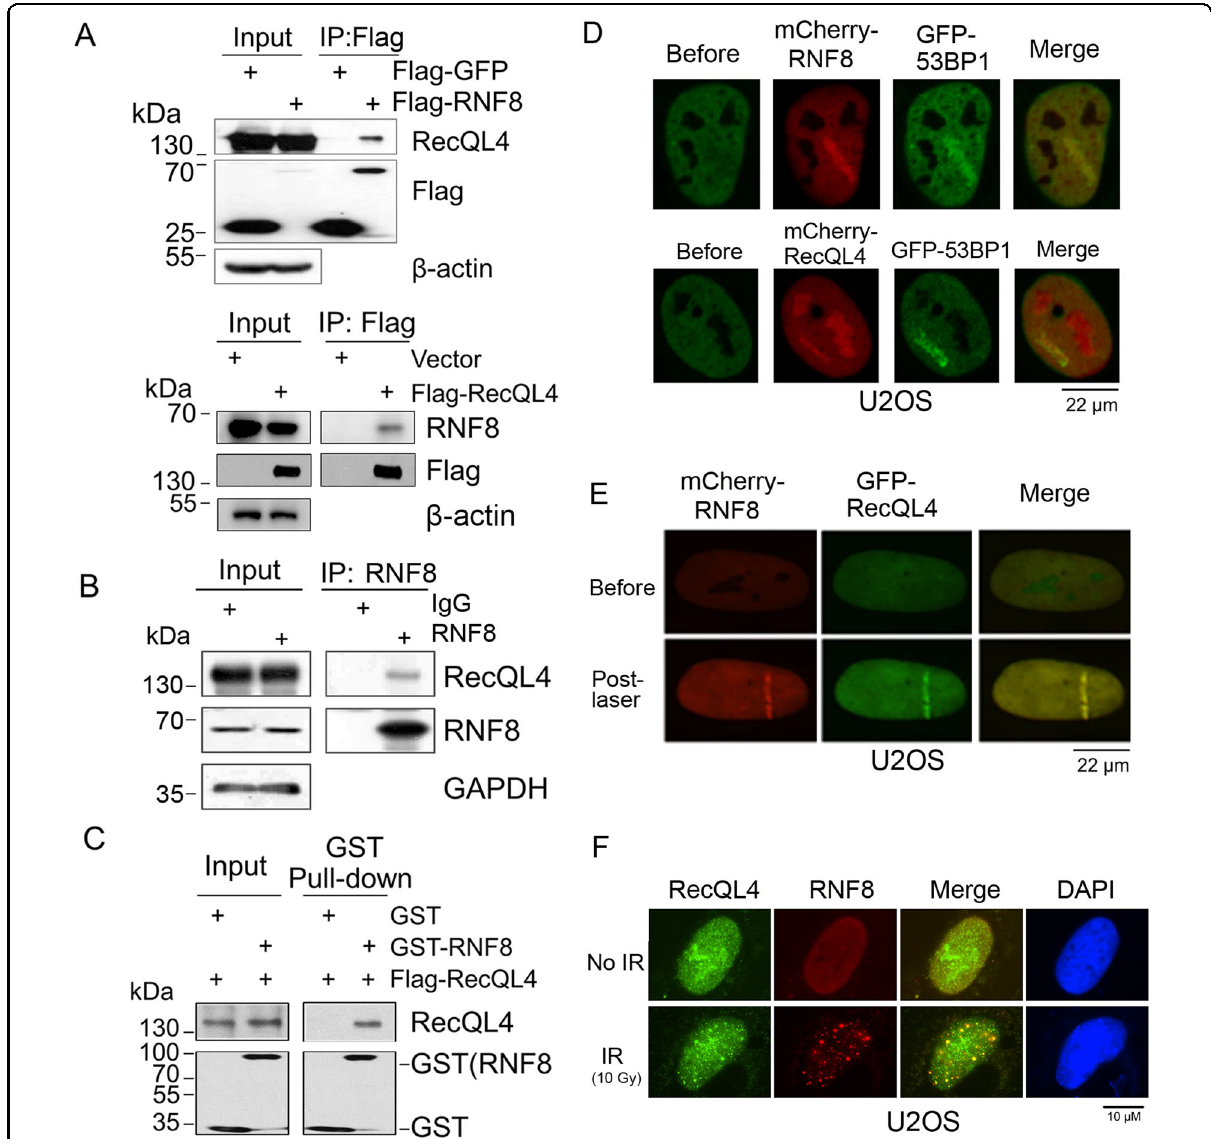
Fig. 1 RecQL4 physically interacts with RNF8. A Endogenous RecQL4 or RNF8 were detected in anti-Flag immunoprecipitated fractions from Flag- RNF8/Flag-RecQL4 transfected U2OS cells by western blotting analysis. Flag-GFP/Empty vector-transfected cells were used as negative controls. B Interaction between endogenous RecQL4 and RNF8. Immunoprecipitated fraction from U2OS lysate was prepared using anti-RNF8 antibody (14112- 1-AP, Proteintech), followed by western blotting analysis with anti-RecQL4 (25470002, SDIX) or RNF8 antibodies (sc-271462, Santa cruz). RecQL4 protein was detected in the RNF8 immunoprecipitated complex. C Direct interaction between RecQL4 and RNF8 was demonstrated by an in vitro pull-down assay. Puri fi ed recombinant GST-RNF8 was immobilized on Glutathione resin and incubated with puri fi ed Flag-RecQL4 in the IP buffer, and the bound proteins were examined by western blotting. D Colocalization of GFP-tagged 53BP1 and mCherry-tagged RNF8/RecQL4 at DSB track induced by UV micro-point laser. E Co-localization of mCherry-RNF8 and GFP-RecQL4 at DSB track induced by UV micro-point laser. F Co-localization of endogenous RNF8 and RecQL4 after X-ray irradiation. U2OS cells were exposed to 10 Gy of X-ray irradiation (25 mA, 160 kV; dose rate 0.995 Gy/min, X-RAD RS2000, Rad Source, USA), and fi xed with 4% paraformaldehyde at 3.5 h post treatment. Indirect immunostaining was performed using primary anti-RecQL4 and RNF8 and fl uorescence-dye conjugated secondary antibodies. After counterstaining with DAPI, images were captured using a fl uorescence microscope (Leica DM5000